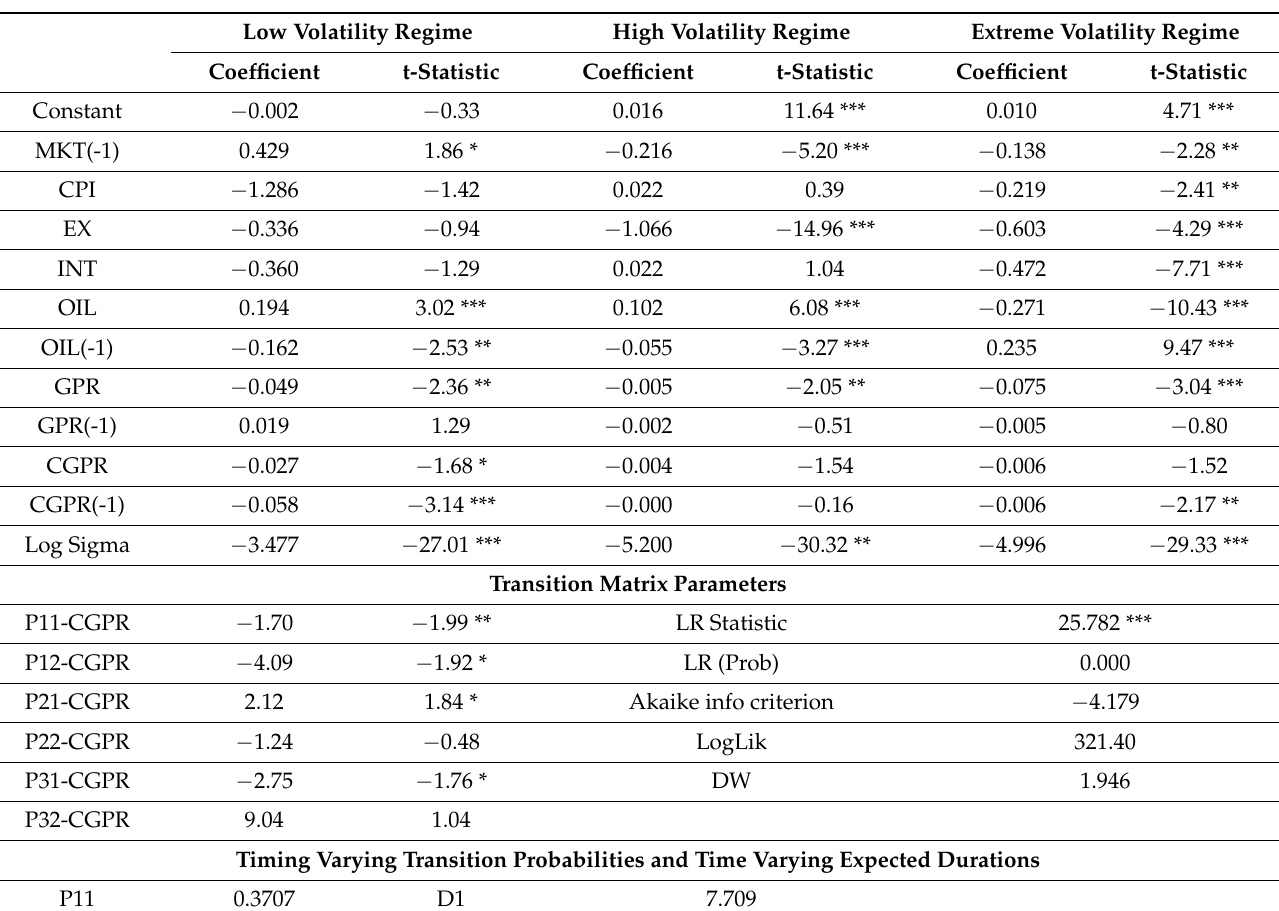
Table 3. Results of MS Regression for Conventional Stock Market.